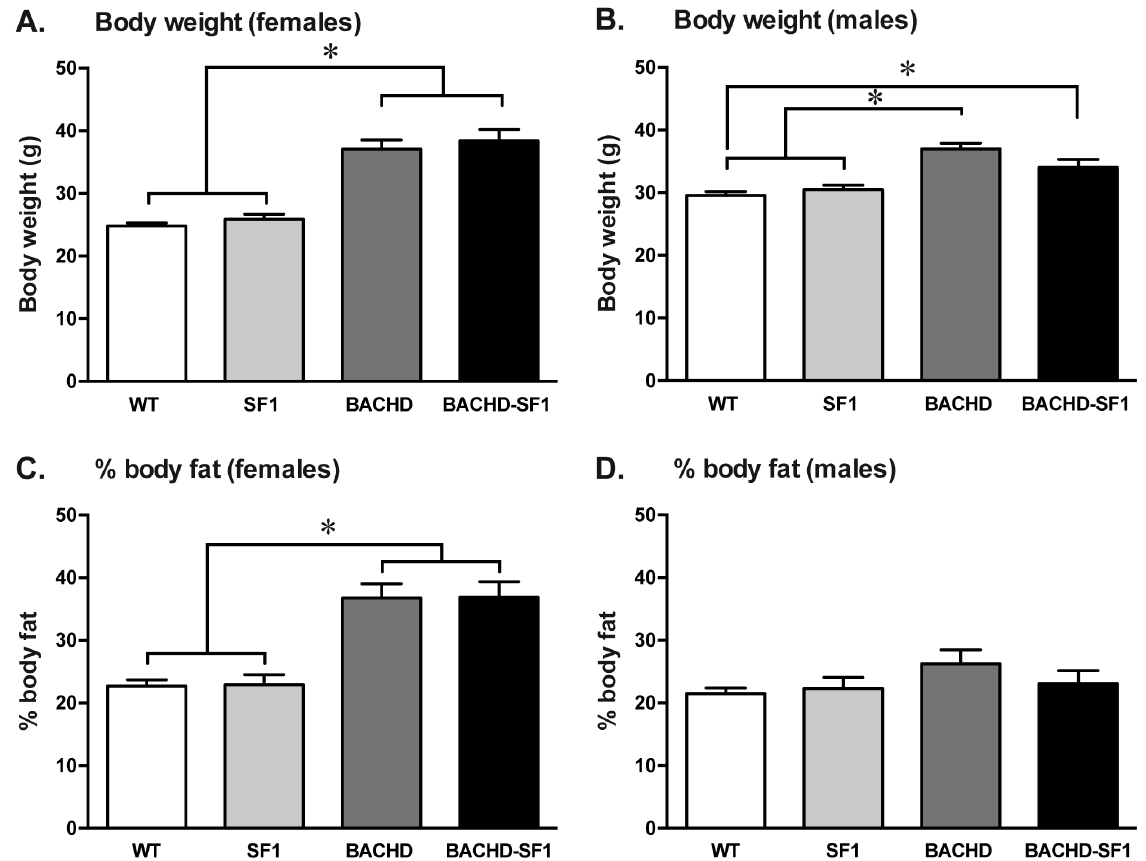
Figure 2. Increased body weight and body fat in 4 months old BACHD and BACHD-SF1 mice. A, B. Body weight were measured in (A) females and (B) males of each genotype. In females, the body weight of BACHD and BACHD-SF1 mice were significantly higher than WT and SF1 control mice. In males, the body weight of BACHD mice were significantly higher than WT and SF1 controls while the body weight of BACHD-SF1 mice were significantly higher than WT mice but not SF1 controls. C, D. The percentage of body fat, as determined by whole body dual energy x-ray absorptiometry (DEXA), revealed a corresponding increased body fat percentage in (C) female BACHD and BACHD-SF1 mice when compared to their WT and SF1 control counterparts but not in (D) males. Data presented as mean 6 SEM (A–C, * p , 0.05, one-way ANOVA with Tukey’s multiple comparisons post-hoc test, D, Kruskal-Wallis non-parametric ANOVA with Dunn’s multiple comparisons post-hoc test), n=11–28/genotype/sex in each group. Detailed statistical analyses are outlined in Figure 2 of Statistical Results S1.